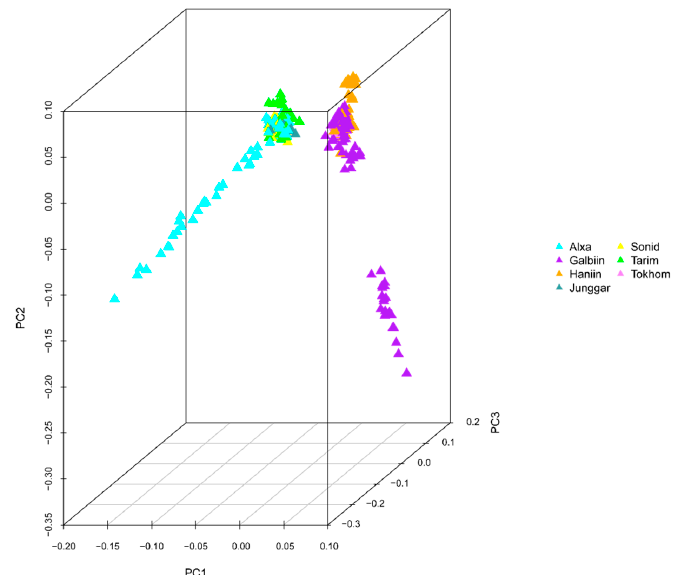
Figure 1. Systematic evolutionary tree of 366 Bactrian camels.